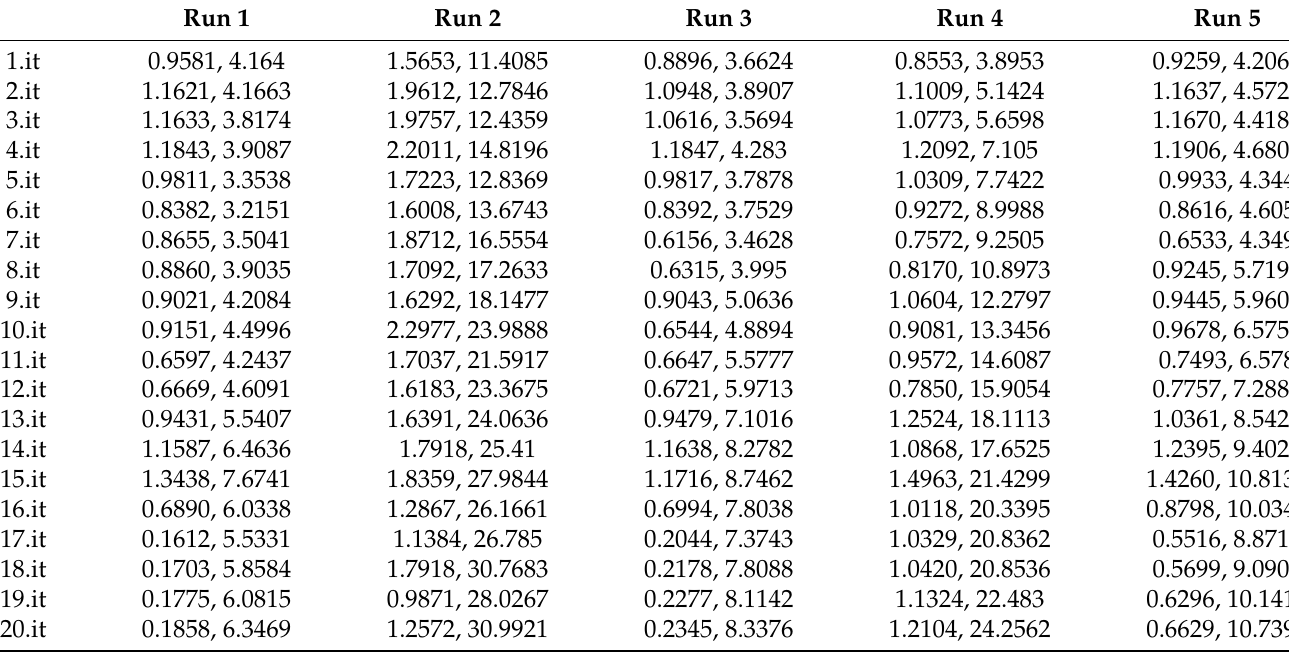
Table 12. The distances (Euclidean, Manhattan) between the testing and the proposed algorithm in 2020 points for (cid:96) =